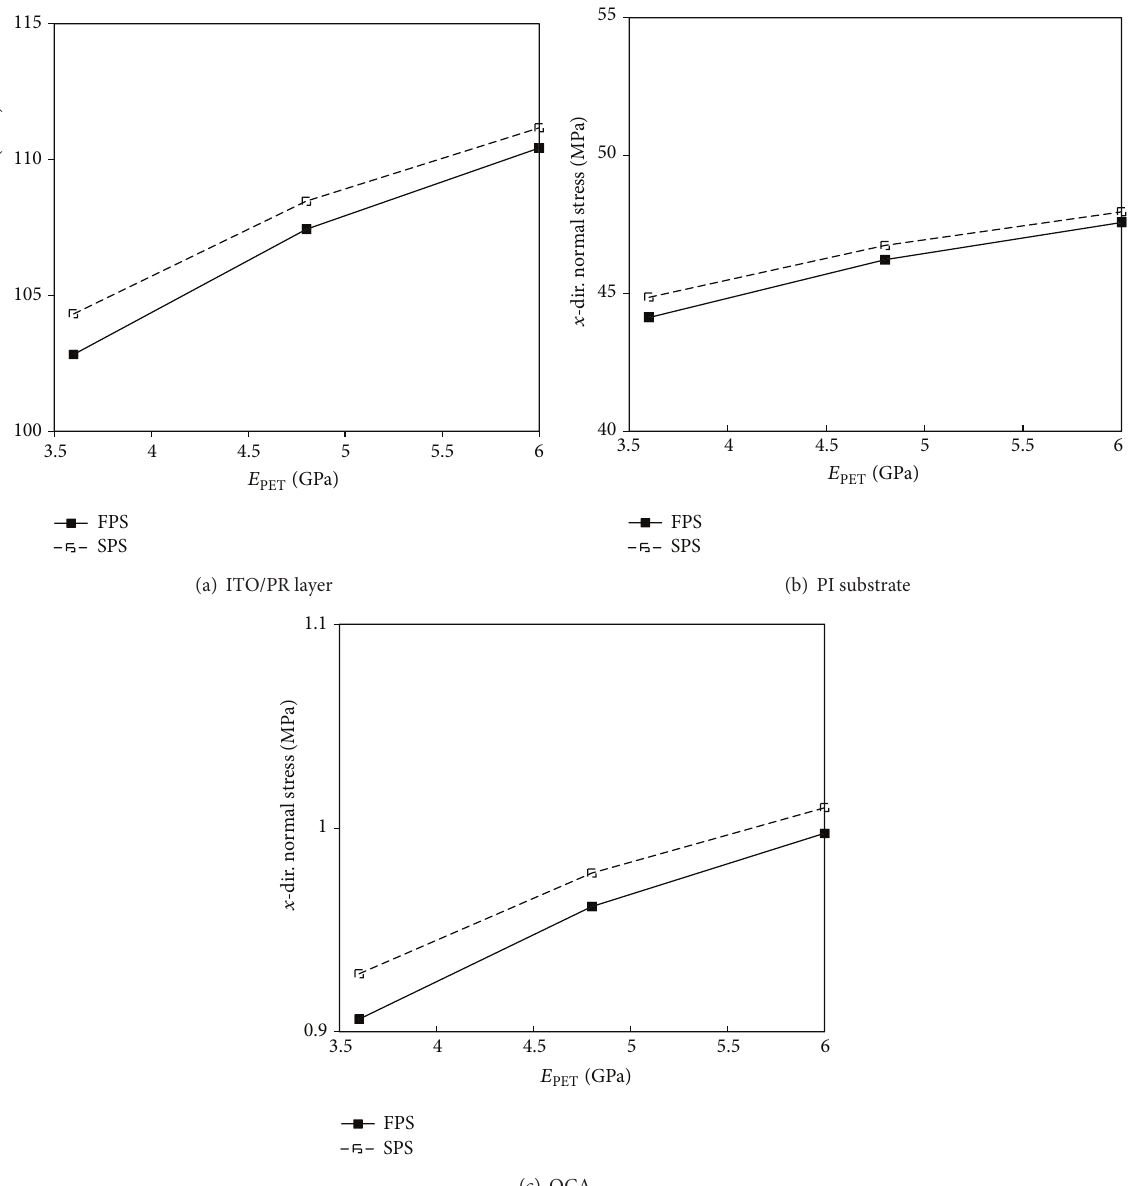
Figure 11: Effects of Young’s modulus of display panel substrate on the bending stress of the